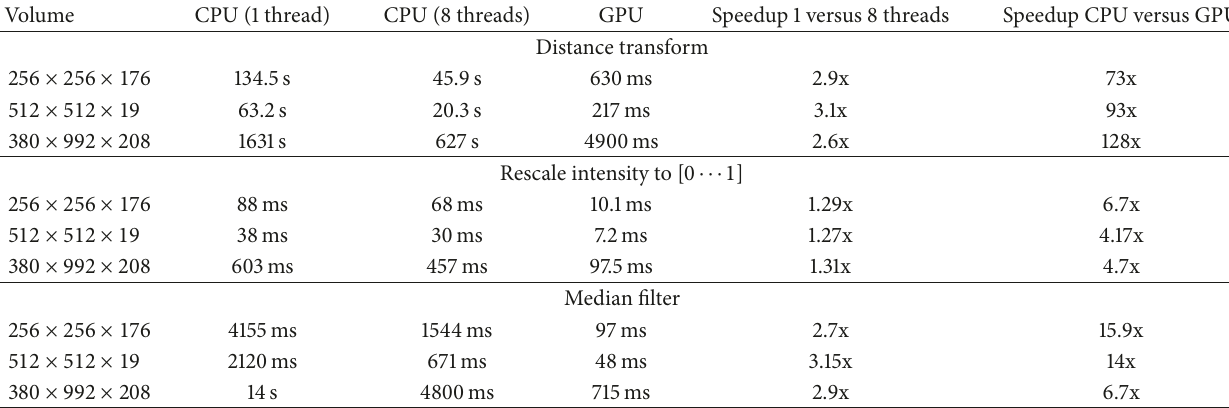
Table 1: Timings for selected operations on 3 different volumes. The speedup factor between CPU and GPU is calculated as the lowest CPU time (8 threads) divided by the GPU time. The 3D Euclidian distance transform operates on normalized (pixel values in [0 ⋅⋅⋅1] ) volumes with a solidity threshold of 0.5. The CPU implementation is our own, including the multithreading. Intensity rescaling and median filtering use ITK’s CPU-based implementation. The median filter takes the direct neighborhood of each voxel into account, that is, a box of 27 voxels in